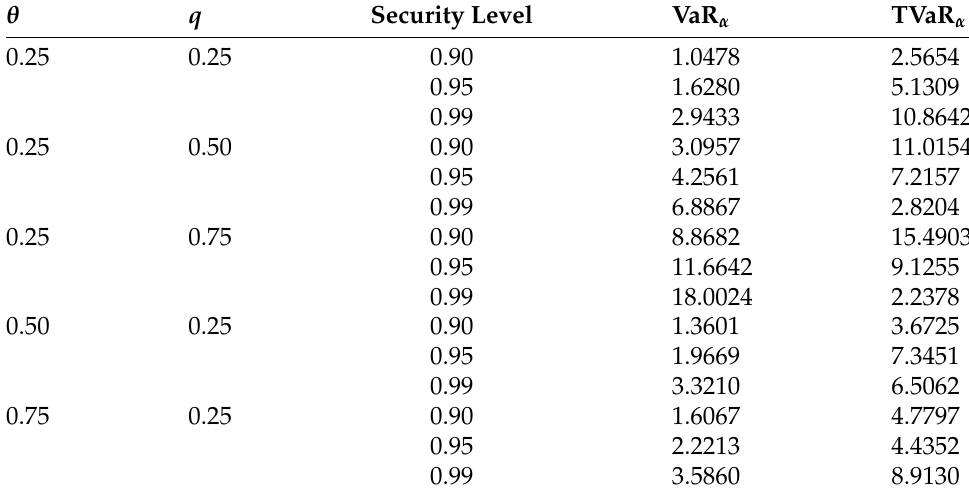
Table 2. Numerical values of VaR α and TVaR α measures of the TRTG